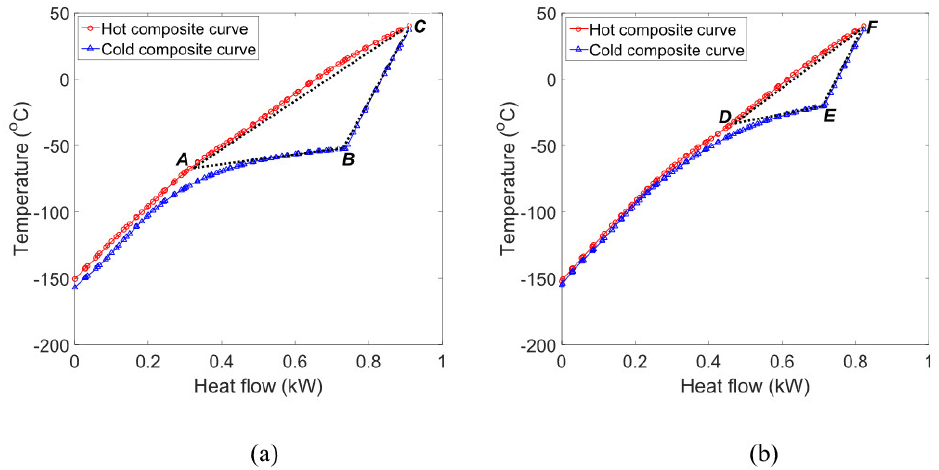
Figure 47. Composite curves of ( a ) conventional mixed refrigerant; ( b ) with the addition of n- butane [188]. Reproduced with permission from Elsevier (license number